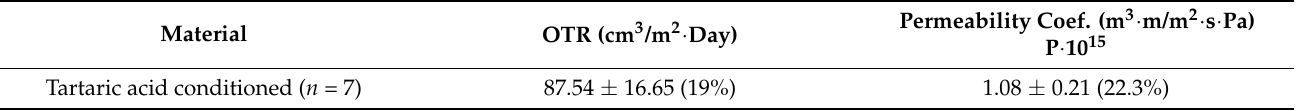
Table 12. Main permeation results of tested C-DVTec pieces in liquid contact mode.